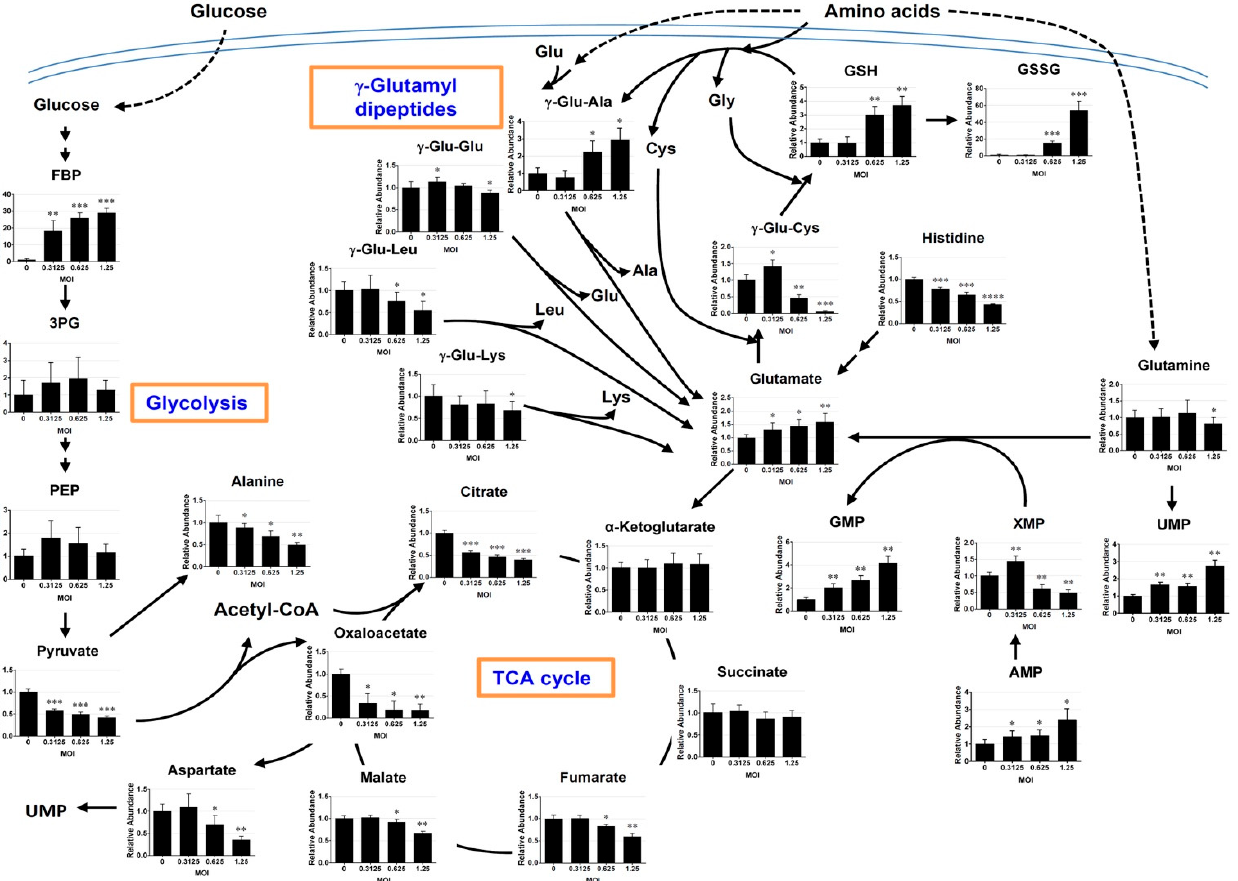
Figure 3. EV71-induced changes in metabolism of epithelial cells. Vero cells were infected and extracted for metabolomic analysis as described in Figure 1. The features of interest were extracted, and the validated metabolites of interest were mapped onto biochemical pathways. The levels of metabolites are expressed relative to those of mock-infected cells. The arrow indicates the metabolic pathway, and the dashed one indicates the transport of biomolecules. Data are mean ± SD (n = 9). * p < 0.05, ** p < 0.01, *** p < 0.005, significant difference from mock-infected cells.